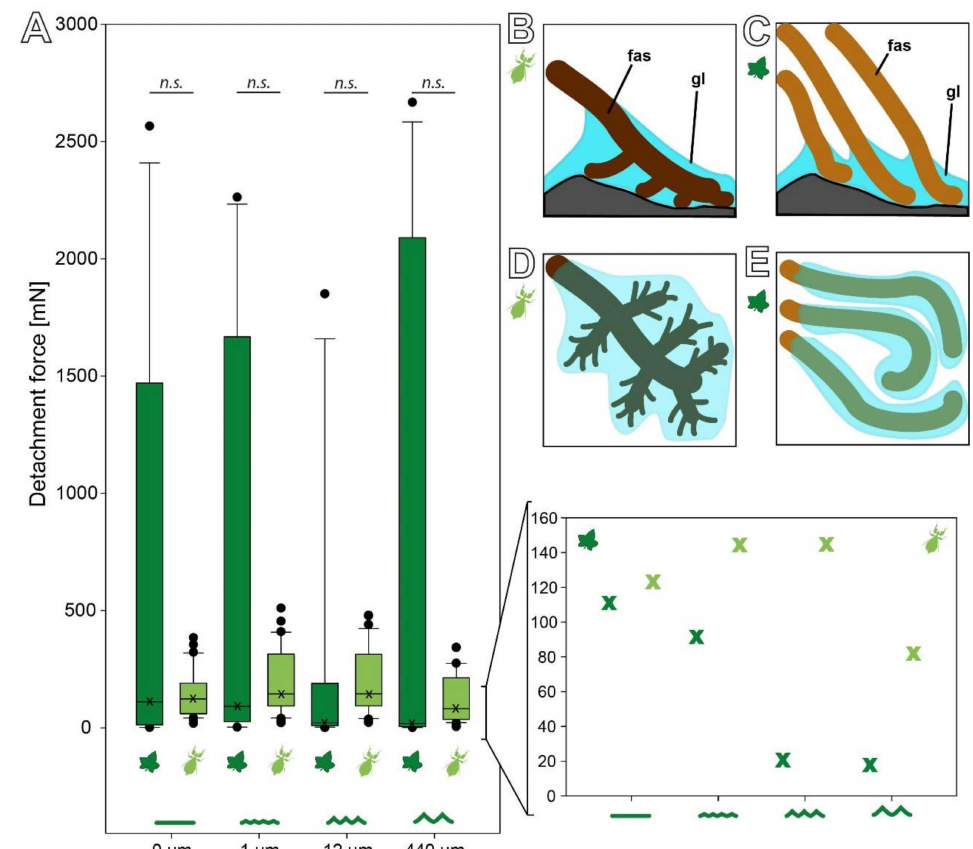
Figure 7. Comparison of the detachment forces of seeds and eggs on substrates with different substrate roughness. ( A ) Detachment forces are represented by box plots. Boxes indicate the 25th and 75th percentiles, the line represents the median, and the whiskers are the 10th and 90th percentiles. n.s . = no statistical difference p > 0.05; Mann–Whitney rank sum test). Eggs ( N = 32) are shown in light green, seeds ( N = 15) in dark green. The enlargement shows the median of the respective detachment forces for clearer representation. X = median. ( B – E ) Schemes of the contact formation with rough substrates ( B , C ) and the glue distribution ( D , E ) of the expansions of eggs ( B , D ) and seeds ( C , E ). fas = fibrillary adhesive structure; gl =